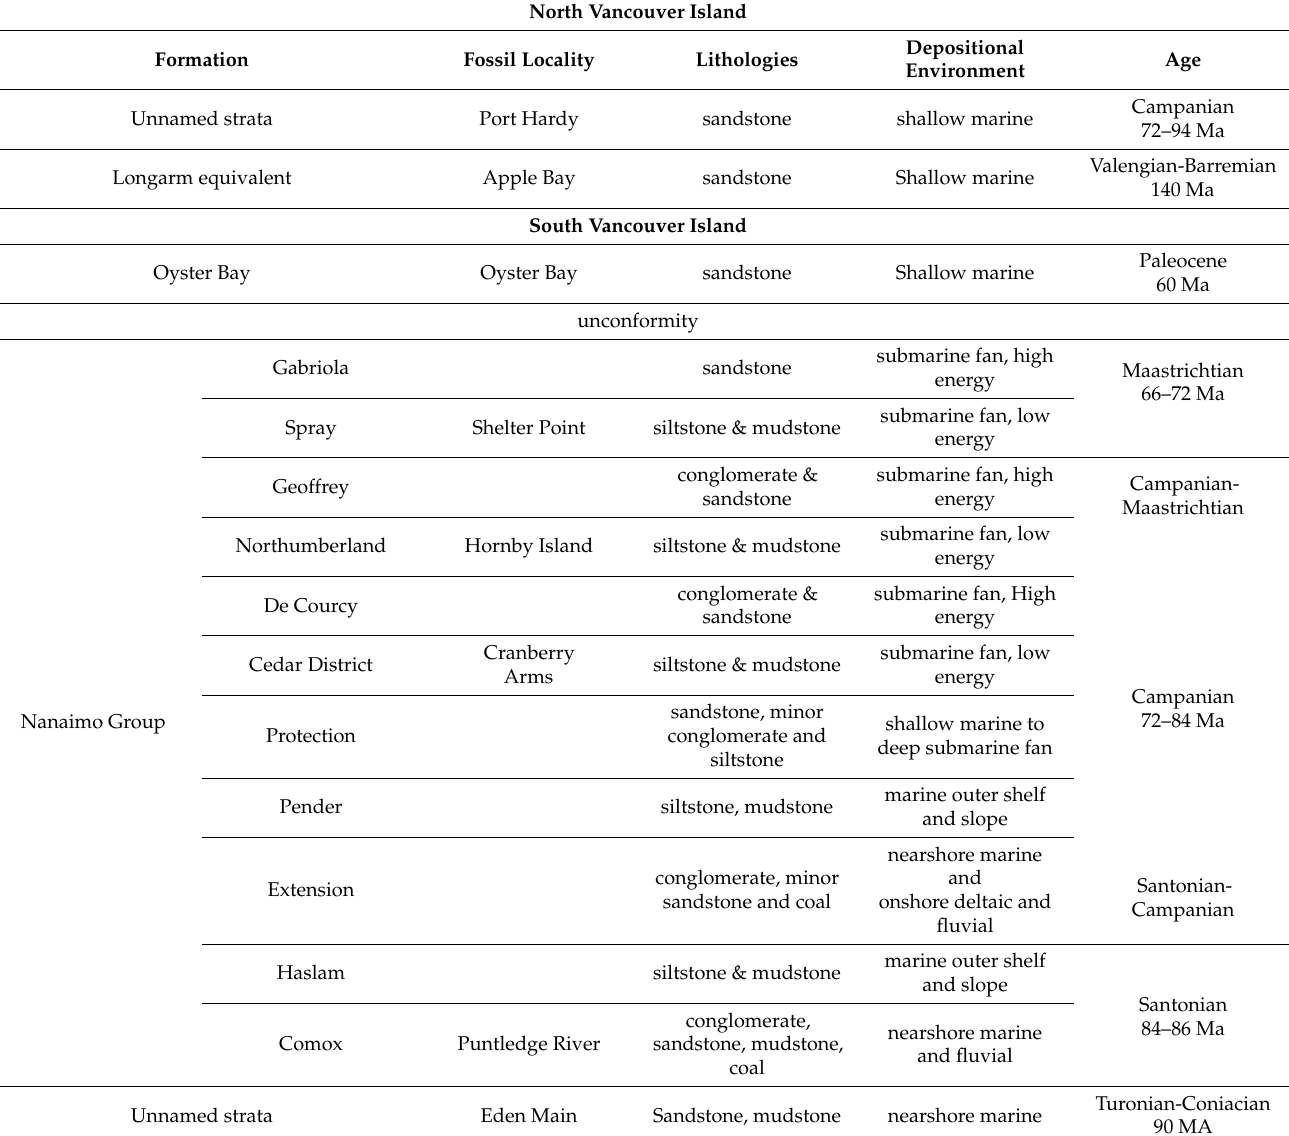
Table 2. Vancouver Island plant fossil localities. Data from [23,32]. North Vancouver